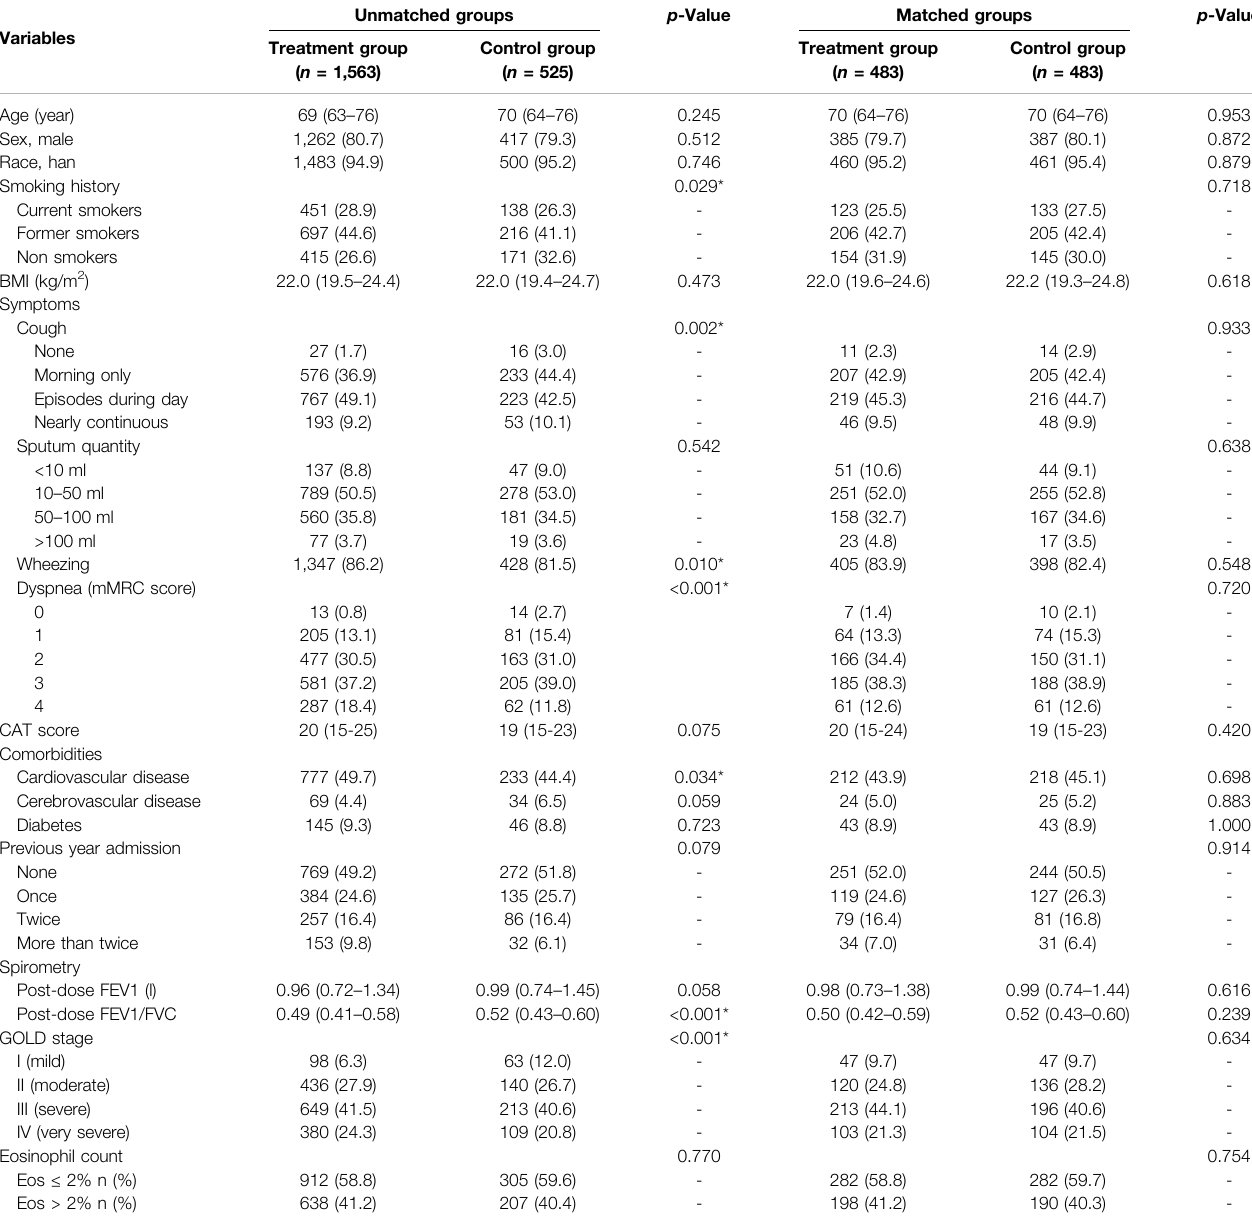
TABLE 1 | Baseline characteristics of hospitalized acute exacerbation of chronic obstructive pulmonary disease patients at